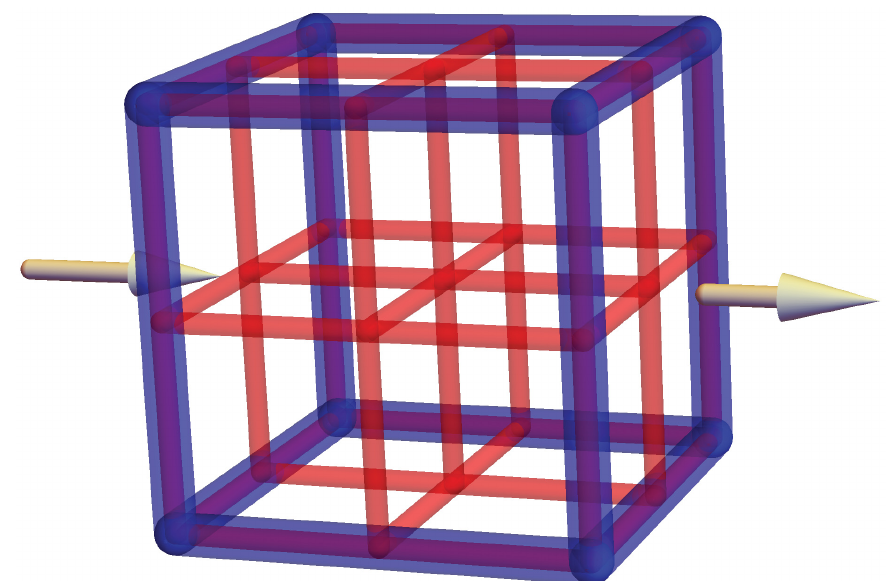
Fig 2. A schematic depiction of the lattice refinement process. The coarse blue network G 1 is replaced by the finer red network G 2 . Both networks fill out the same computational volume. The arrows indicate the direction of the flow through the network.